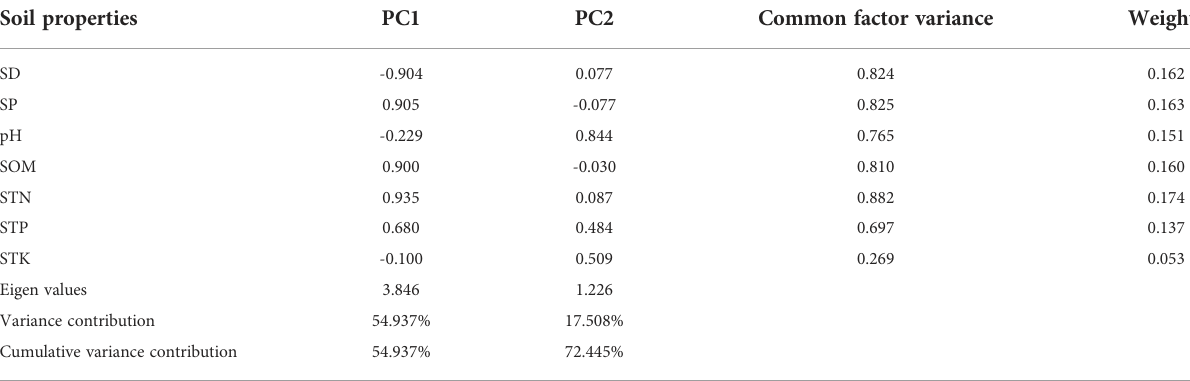
TABLE 3 Results of principal component analysis, factor loadings, common factor variance, and indicators ’